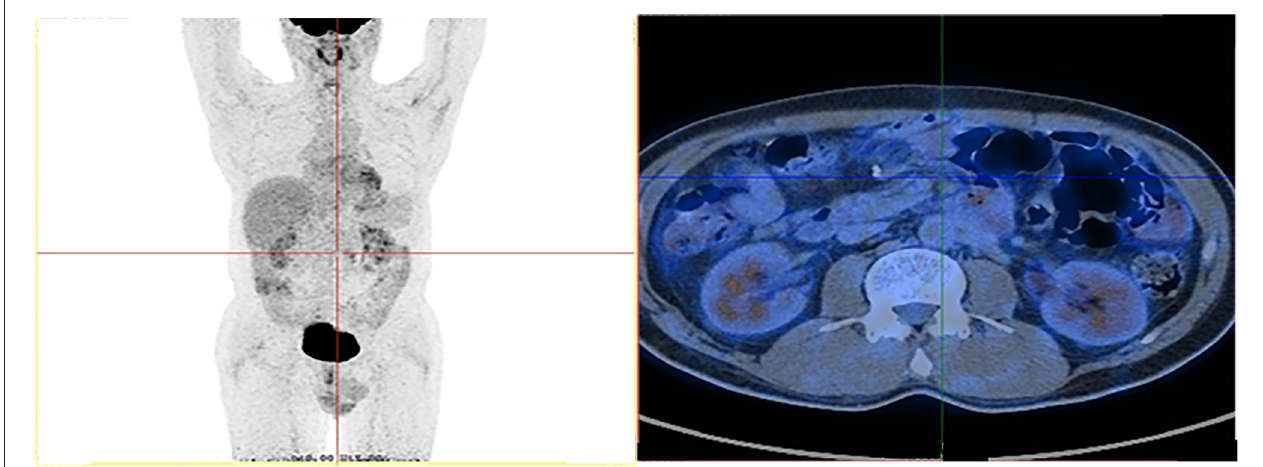
FIGURE 4 | FDG-PET scan shows no metastatic lesions and lymph